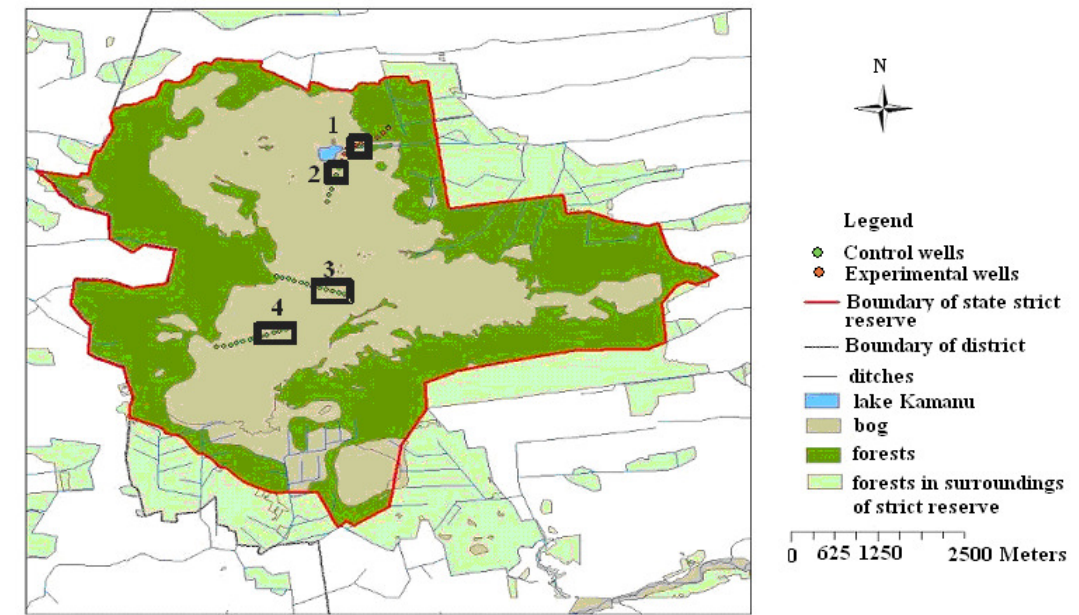
Fig. 1. Layout of the study plots in the bog of Kamanos mire. Study plot 1 is located in the part which was intensively drained in 1907 and the ditches were dammed in 1999. Study plot 2 is located in the part which was extensively drained in 1907 and the ditches were dammed in 1999. Plots 3 and 4 are locatead in undrained part and were used for